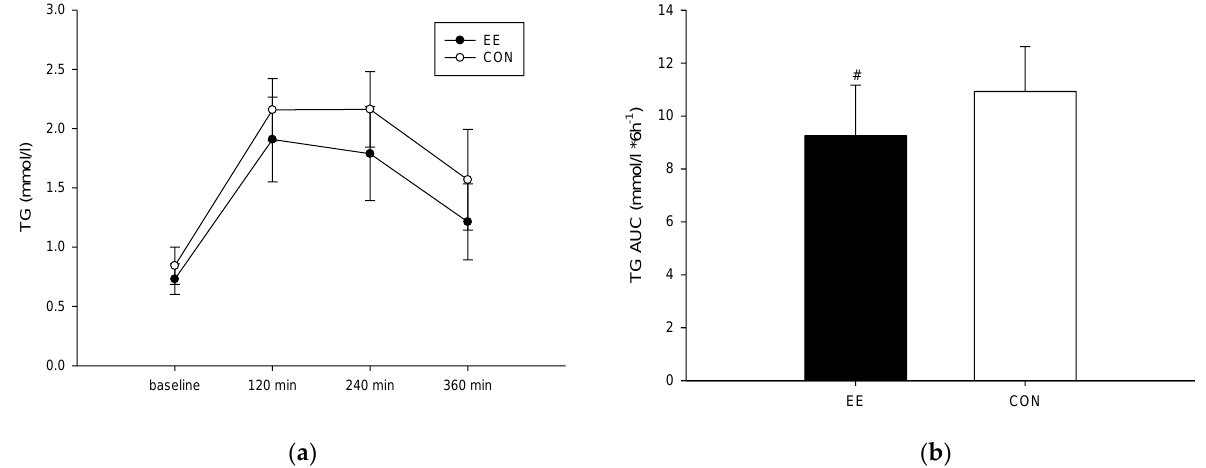
Figure 2. Postprandial plasma triglyceride concentrations ( a ) and the area under the curve ( b ) on the control (CON) ( ○ ) endurance exercise (EE) ( ● ) trials. Values are mean ± SD, n = 8. # EE was the control (CON) ( ) endurance exercise (EE) ( • ) trials. Values are mean ± SD, n = 8. # EE was significantly lower than those for the CON. (cid:35) significantly lower than those for the